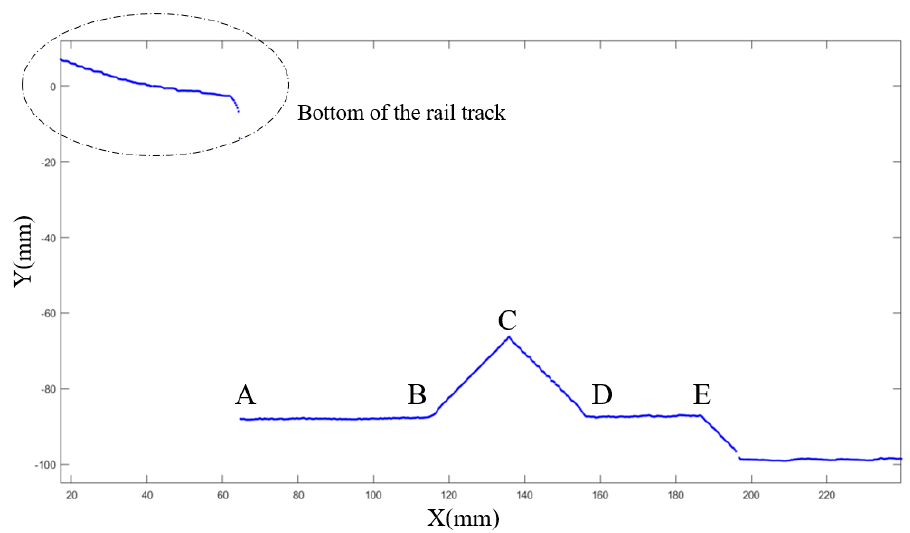
Figure 6. Point cloud of calibration block from structured light sensor.